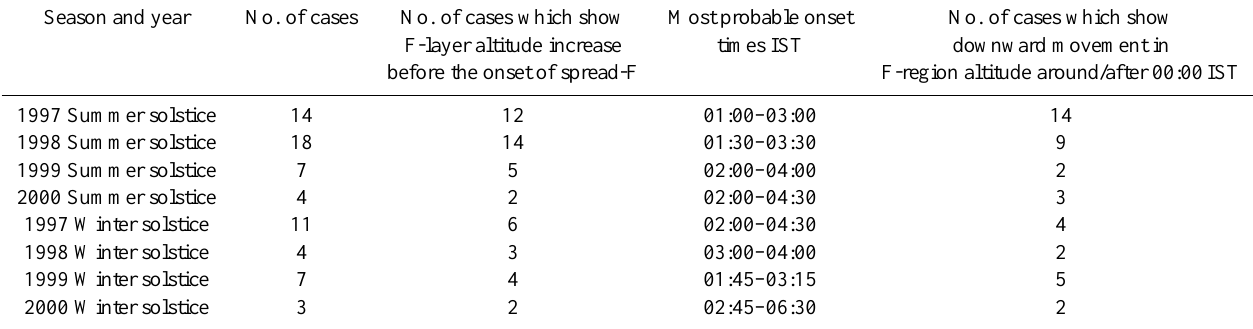
Table 1. Statistical details of post midnight spread-F events Season and year No. of cases No. of cases which show Most probable onset No. of cases which show F-layer altitude increase times IST downward movement in before the onset of